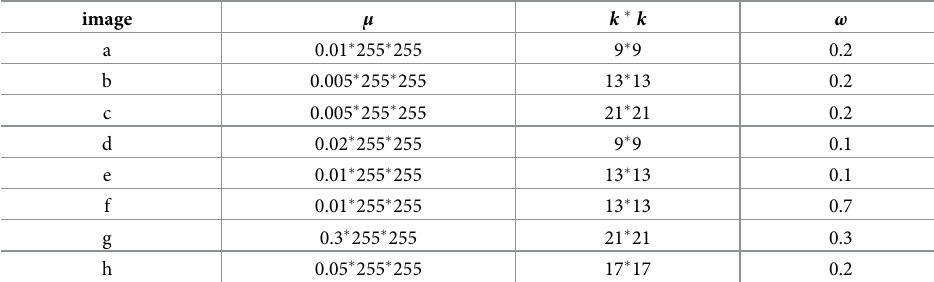
Table 1. The permissible range of length term μ , k and ω used in Fig 5.